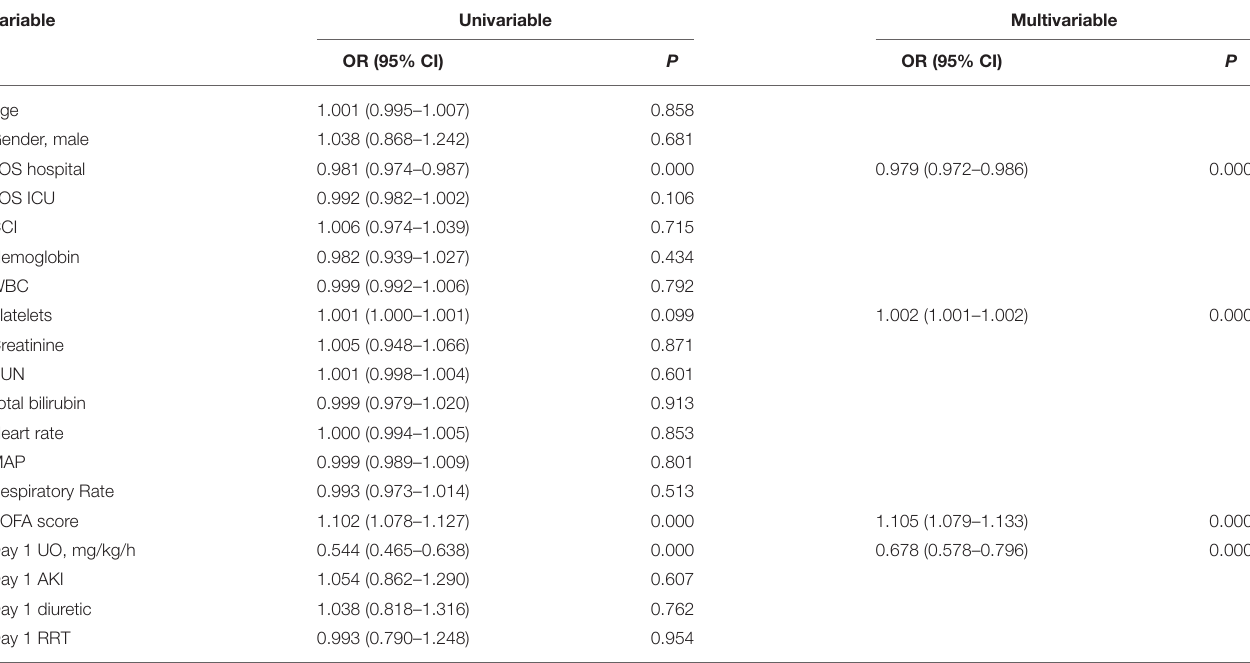
TABLE 3 | Binomial Logistic regression analysis of urine output for in-hospital mortality among intensive care patients with septic shock (after PSM).